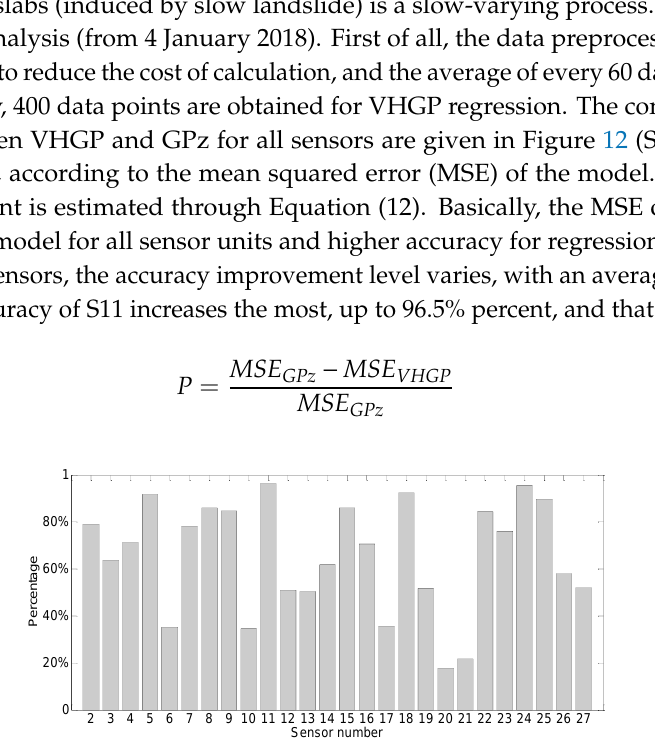
Figure 11. Implementation of SHM system.